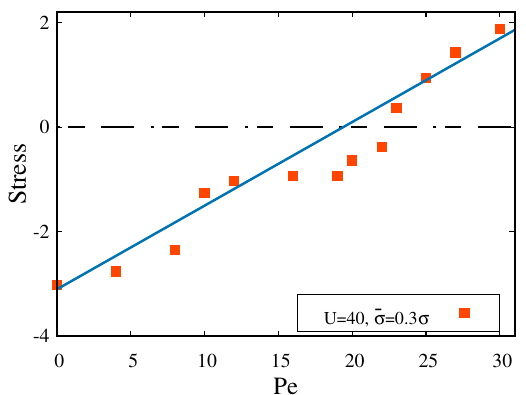
Fig. 4 Activity increases tension. Total central stress calculated in the area starting from the center to a radius 30 σ as a function of activity, Pe, for U = 40 and (cid:1) σ ¼ 0 : 3 σ . The transition from S – V to L – V coexistence occurs at Pe = 23 (compare Fig. 2c), which essentially coincides with Peclet number where central stress changes